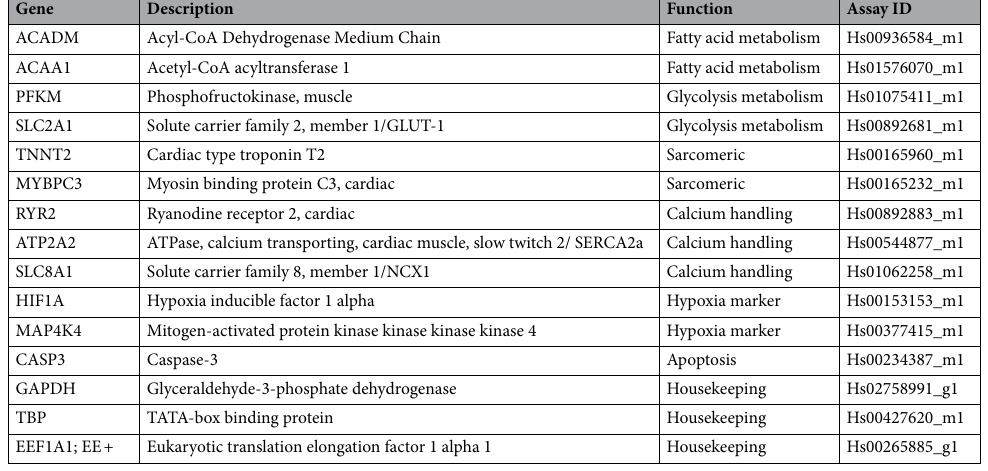
Table 1. TaqMan 20 × Assays used in